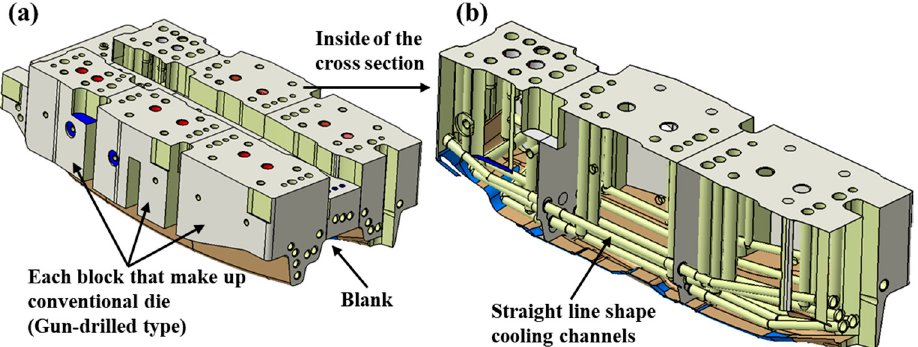
Figure 1. Conventional upper die (Gun-drilled type): ( a ) Shape; ( b ) Cooling channels inside the die.